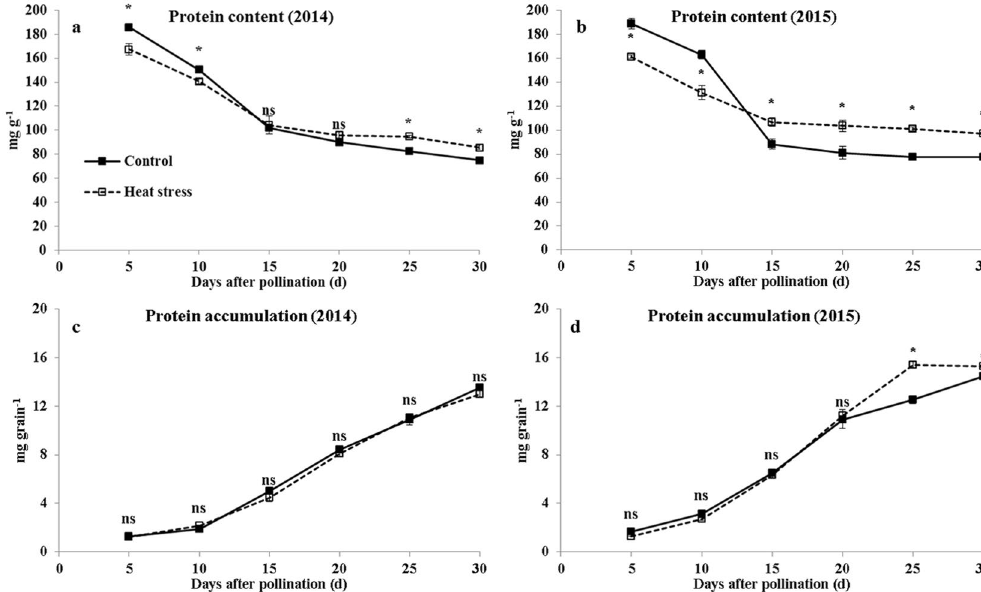
Figure 4. Grain protein accumulation during grain filling under ambient and high-temperature conditions. ( a , c and b , d ) are the grain protein content and protein accumulation in 2014 and 2015, respectively. Bars denote standard errors from three replicates, and one-way ANOVA was used to test for significance at p < 0.05 level.